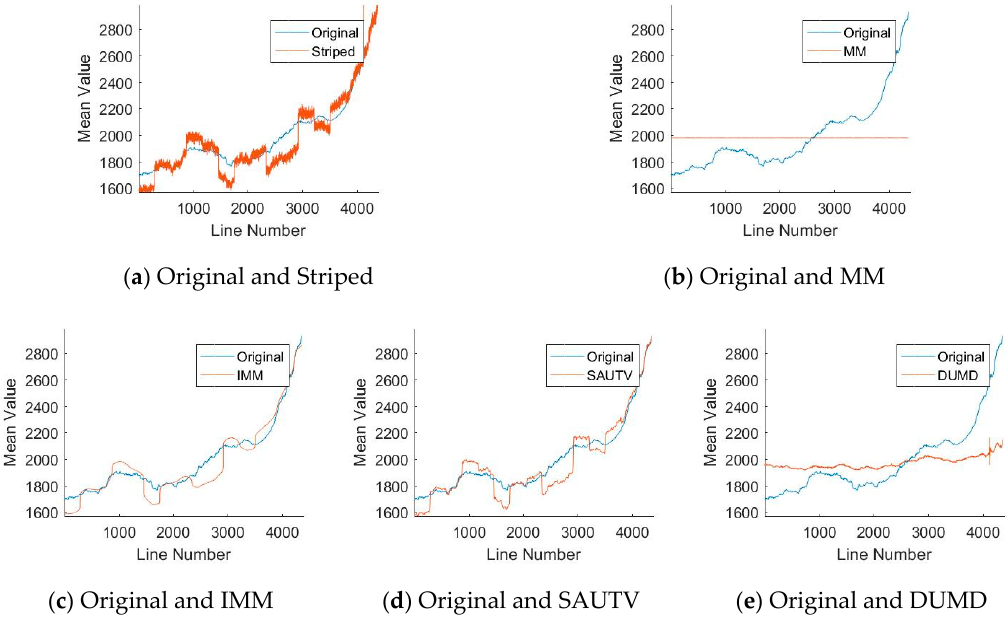
Figure 6. CMVs of Data 3 (GF-1C). Where ( a ) is the CMVs of original image and striped image, ( b ) is the CMVs of original image and MM-processed image, ( c ) is the CMVs of original image and IMM-processed image, ( d ) is the CMVs of original image and SAUTV-processed image, ( e ) is the CMVs of original image and DUMD-processed